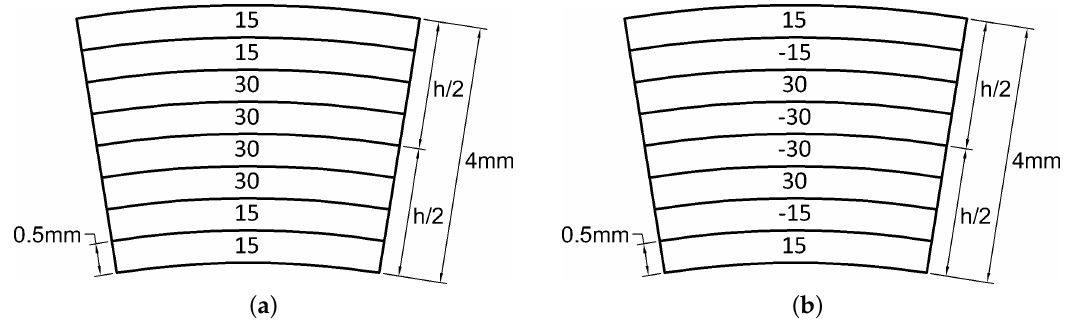
Figure 17. ( a ) The (15 2 /30 2 ) s laminate, ( b ) ( ± 15/ ± 30) s laminate.